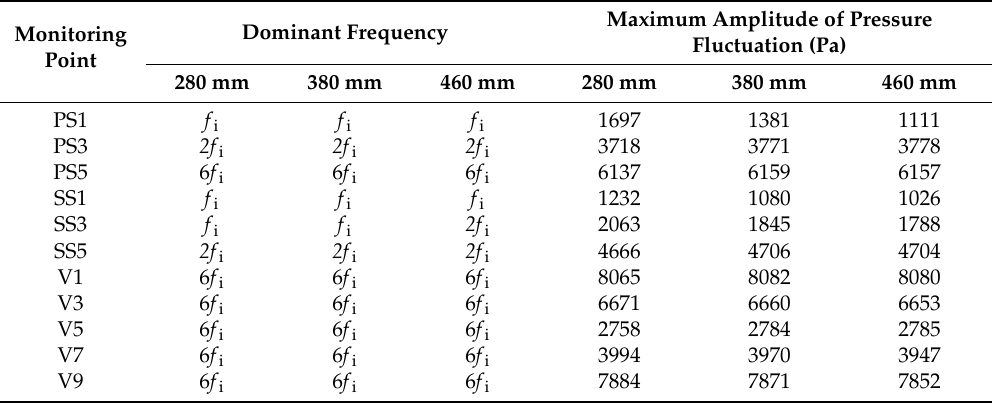
Table 7. Spectrum analysis of pressure fluctuations in pumps with different axial distances ( γ = 0°).